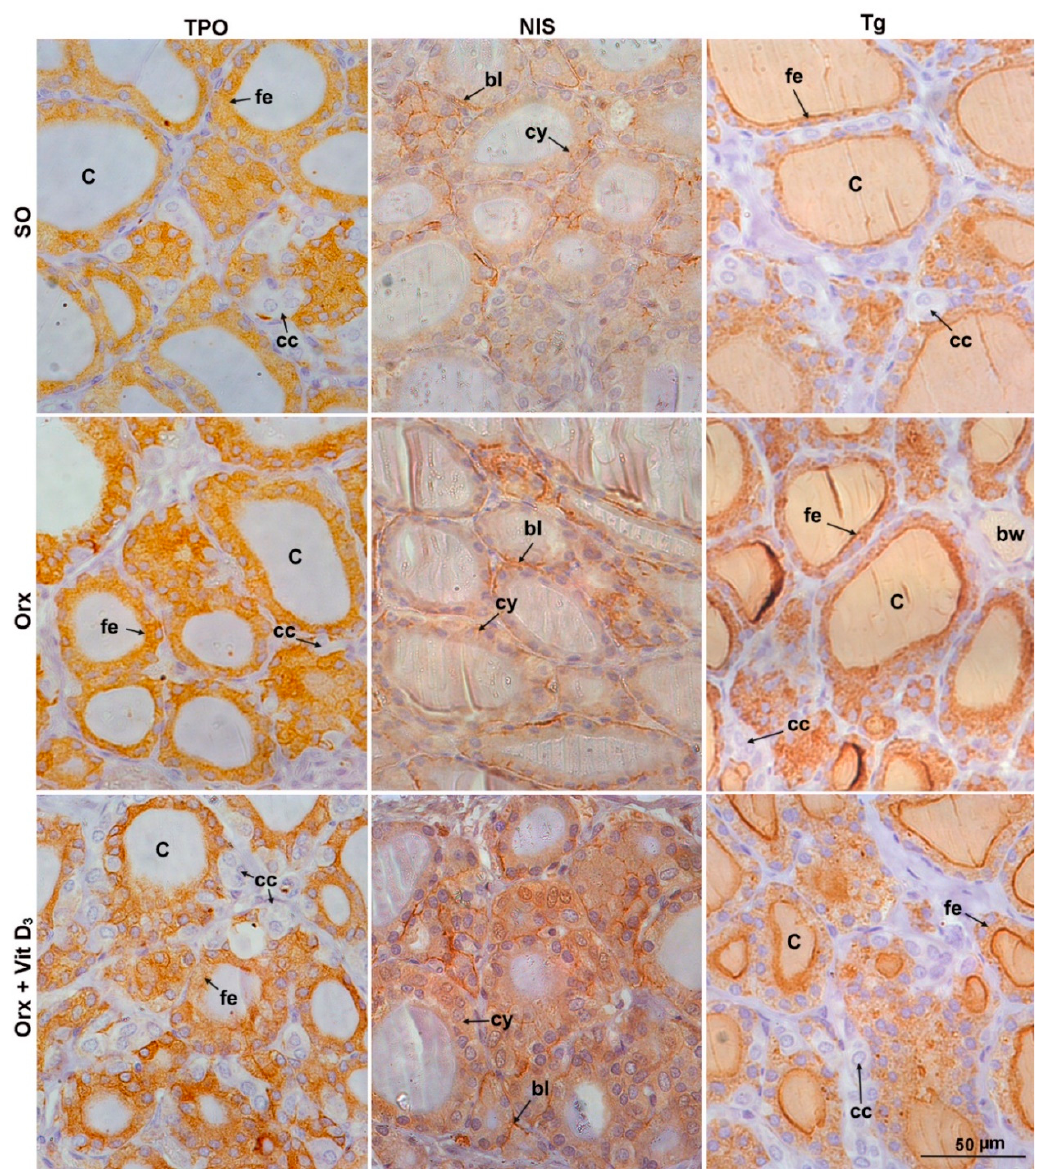
Figure 3. Representative micrographs of immunohistochemical staining showing localization of thyroid peroxidase (TPO), sodium iodide symporter (NIS), and thyroglobulin (Tg) in the thyroid of sham-operated (SO), orchidectomized (Orx) and orchidectomized cholecalciferol-treated (Orx + Vit. D 3 ) rats. C, colloid; fe, follicular epithelium; cc, CT-producing cells (C cells); bl, basolateral NIS immunostaining; cy, cytoplasmic NIS immunostaining; bw, blood